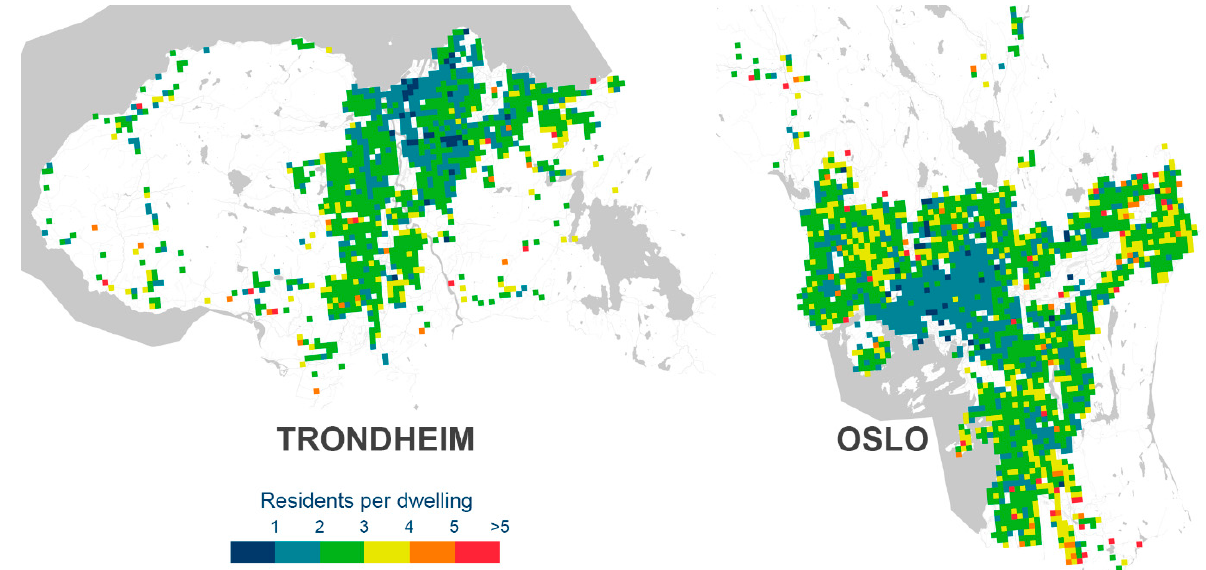
Figure 2. Residents per dwelling for each grid cell in Trondheim and Oslo.